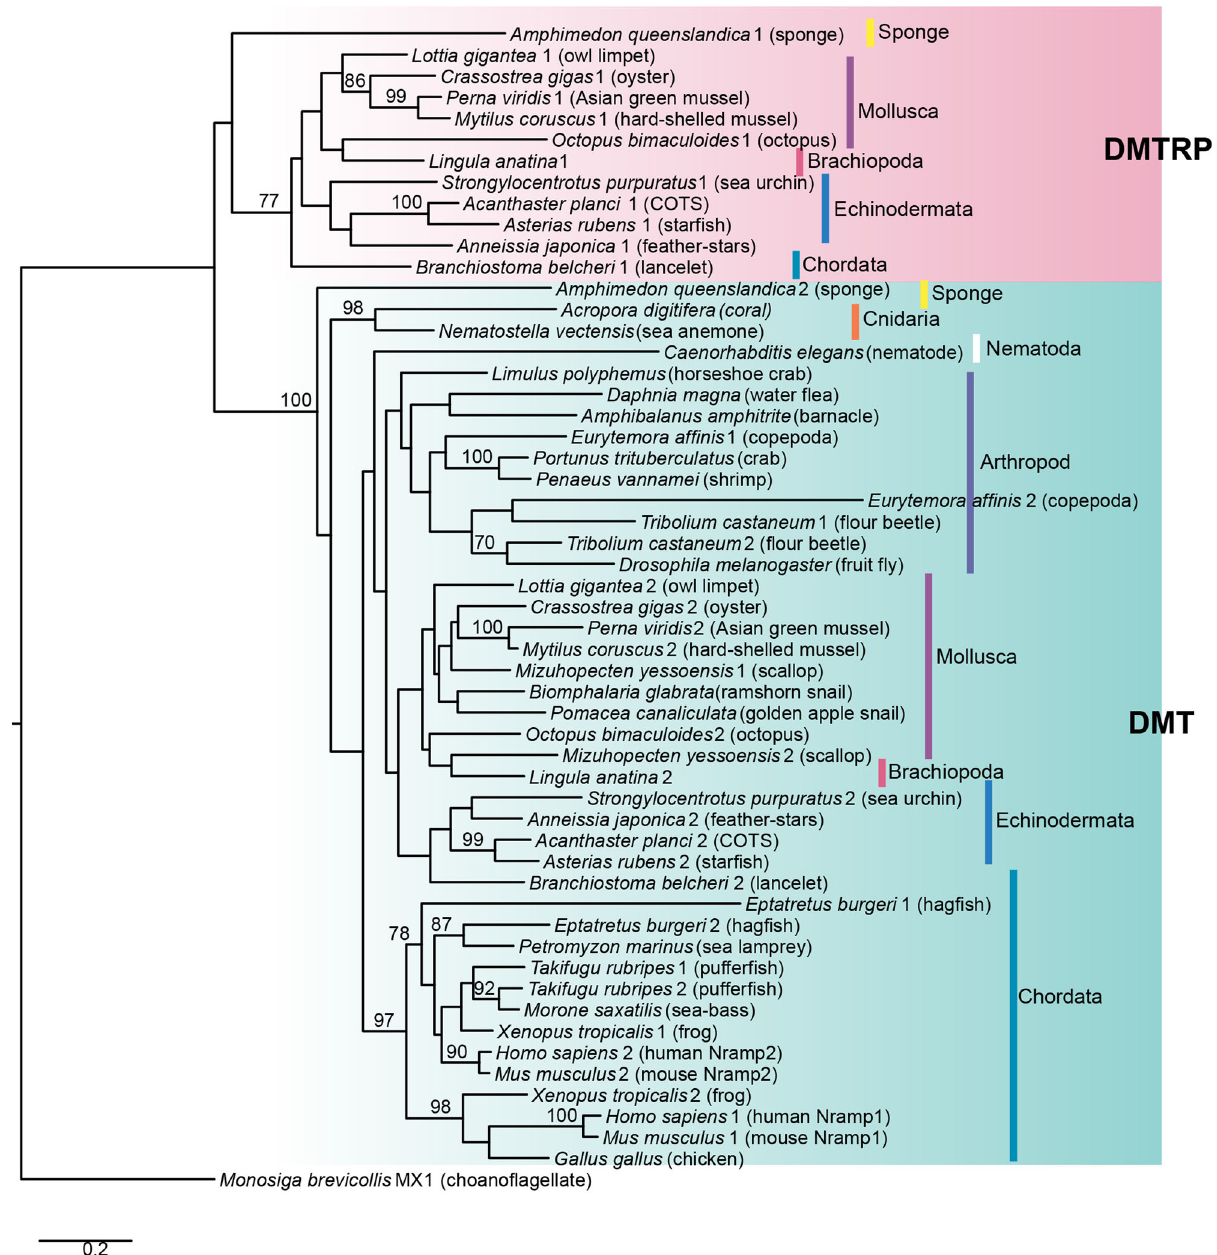
Fig. 4 Maximum-likelihood trees of divalent metal transporter (DMT)-like protein sequences obtained from databases. A tree constructed using metazoan sequences. The tree was rooted using the sequence of a choano fl agellate, Monosiga brevicollis , as an outgroup. Bootstrap values more than 70% are indicated at nodes. The scale bar represents a phylogenetic distance of 0.2 substitutions per